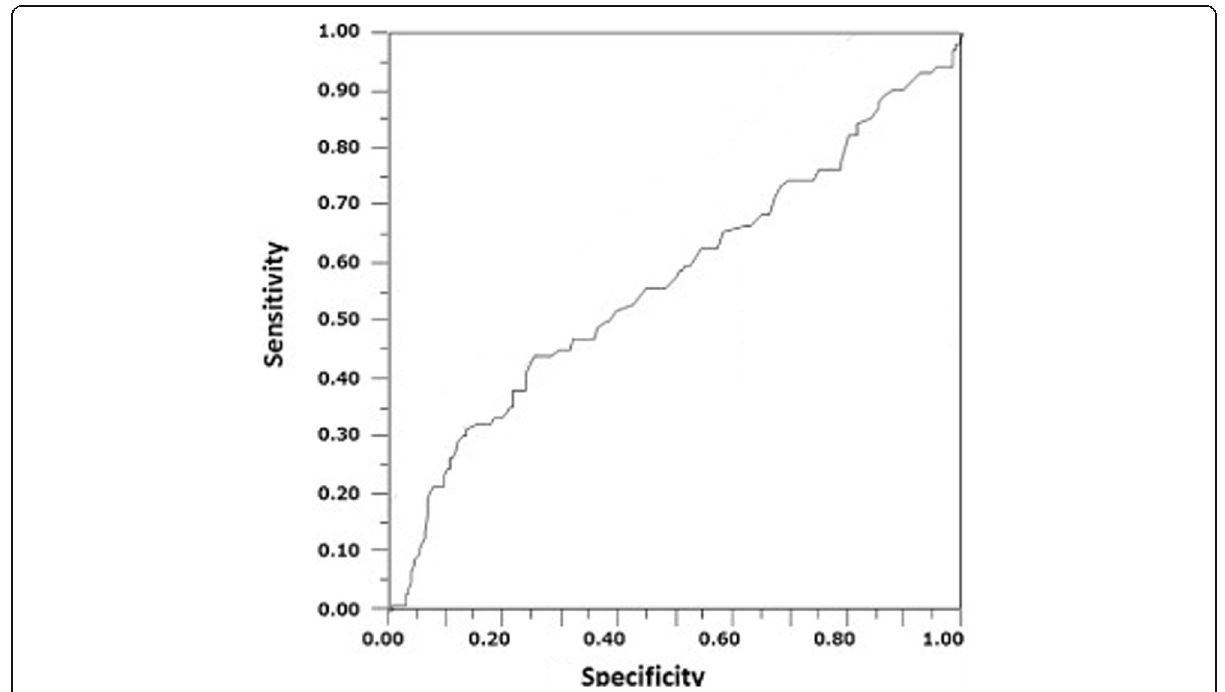
Fig. 2 ROC curve evaluation of systolic BP 6 h after admission and unfavorable outcome after discharge from